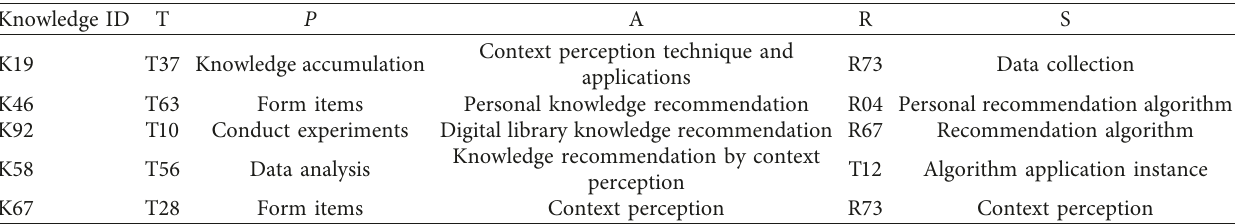
Table 2: Knowledge alternative set from researchers R01.